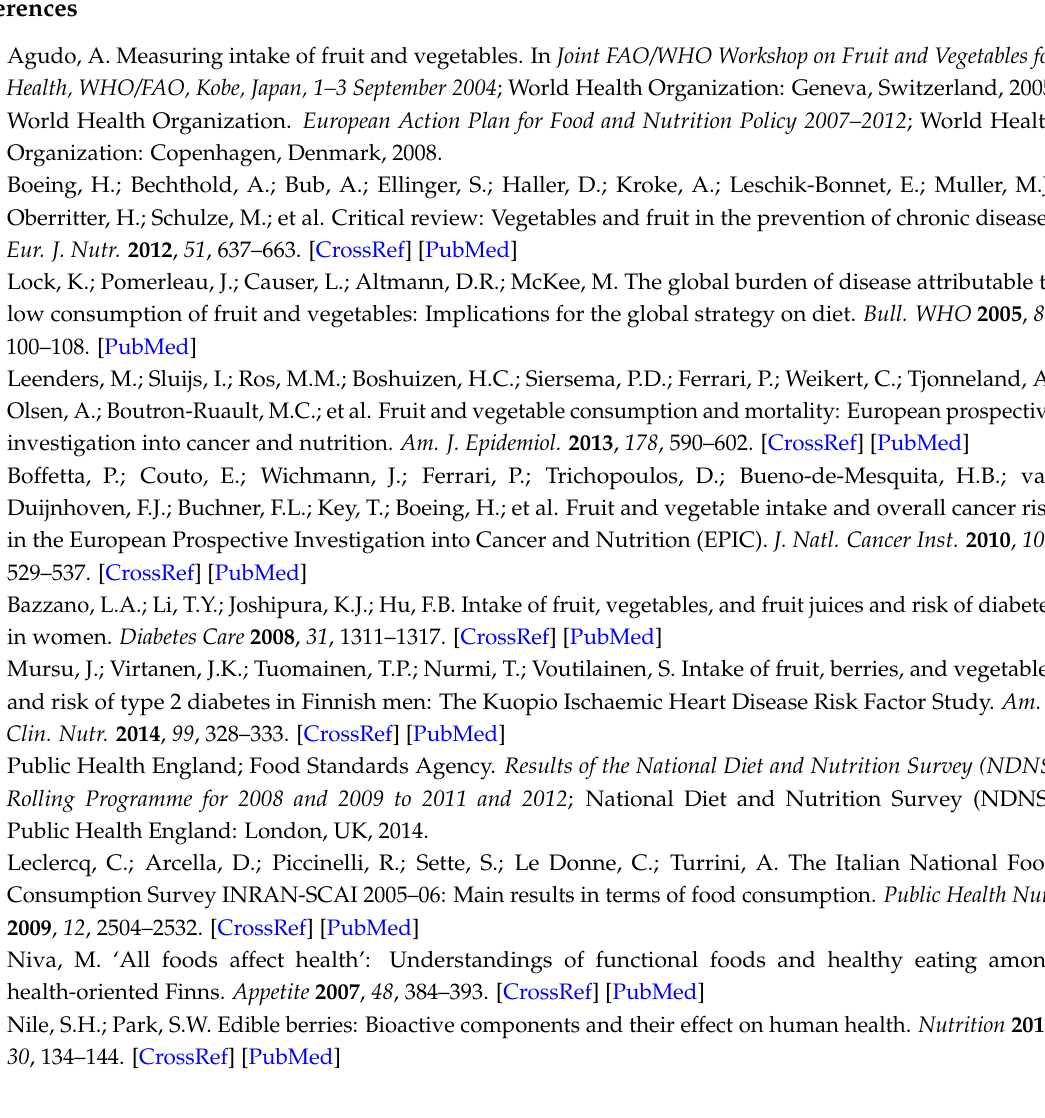
Table S1: List of forbidden and permitted foods during the (poly)phenol-poor diet. Figure S1: Absorption curves of (a) hippuric acid, (b) 4-hydroxyhippuric acid, (c) feruloylglycine. Data are expressed as mean values and bars represent standard error of means